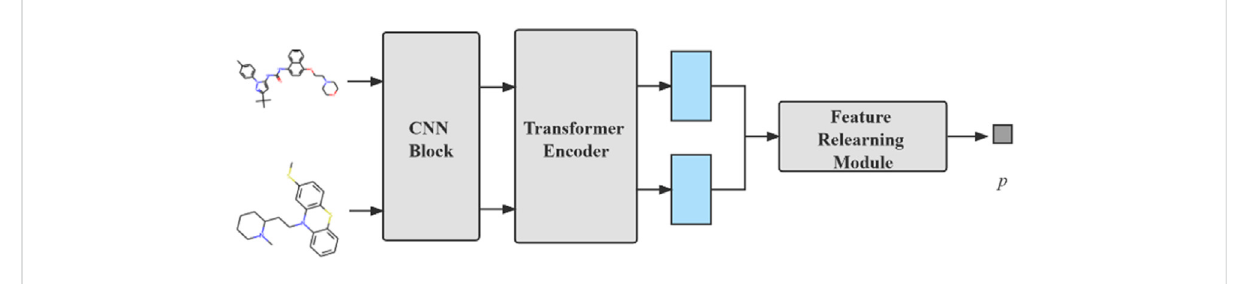
FIGURE 5 The fl owchart of our DDI model. Two pictures are fed into same CNN Block and Transformer Encoder. Then the feature map is stacked to obtain the prediction results by FR module.